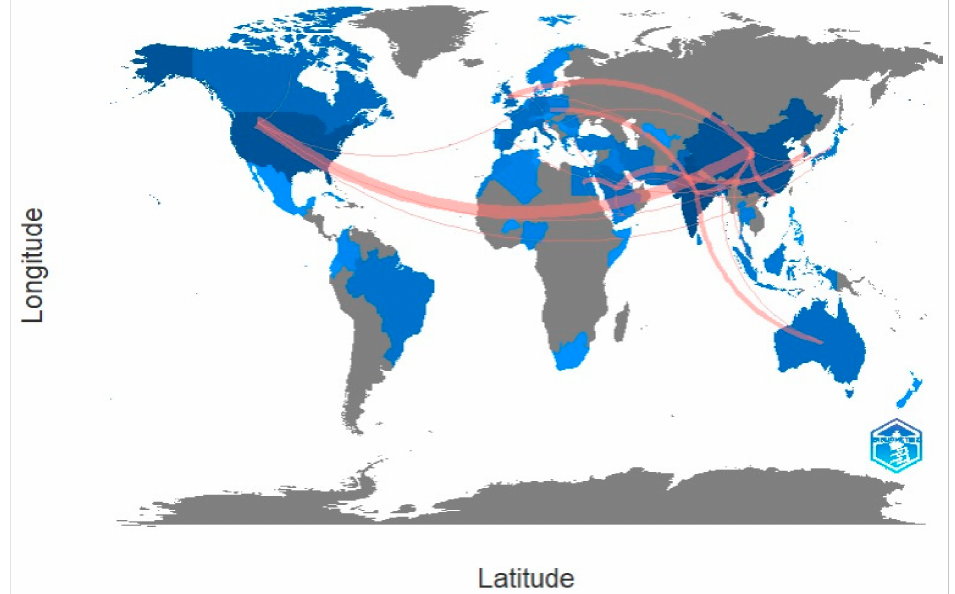
Figure 25. Worldwide collaboration.